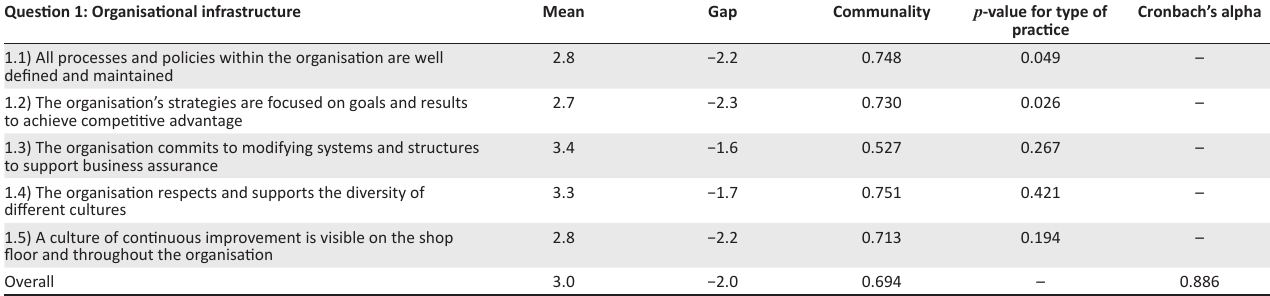
TABLE 2: Results pertaining to organisational infrastructure. Question 1: Organisational